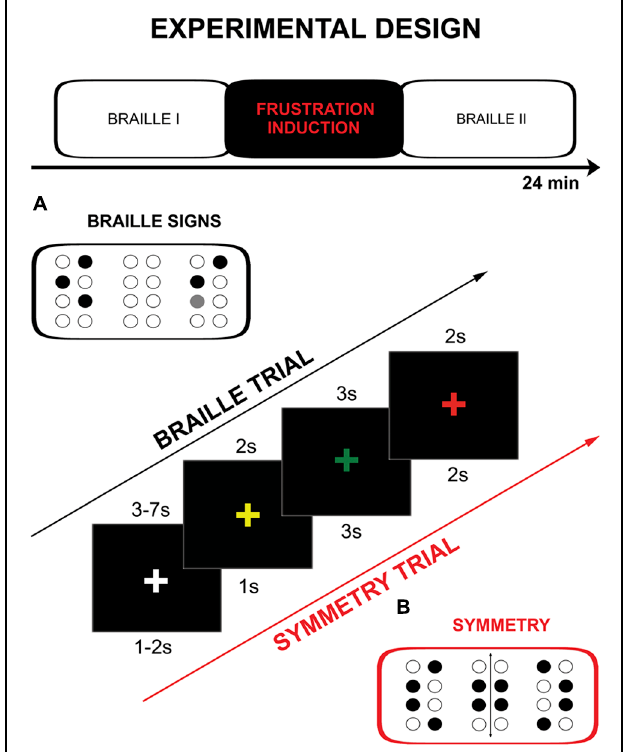
FIGURE 1 | Schema of the protocol including: experimental design, single trial timings and example of the used stimuli: (A) Braille characters, (B) symmetry